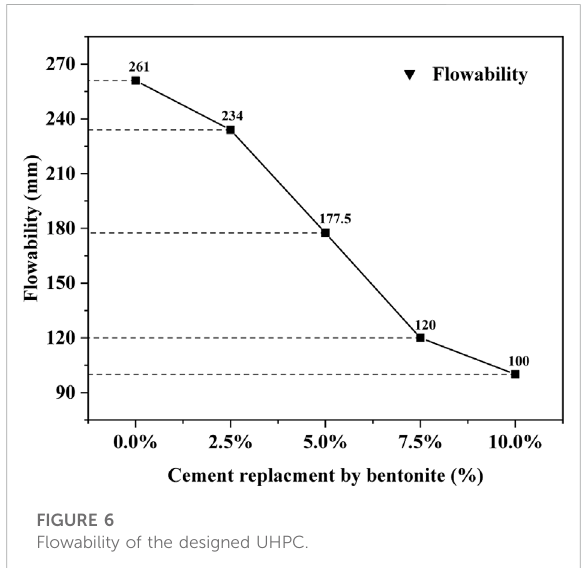
FIGURE 6 Flowability of the designed